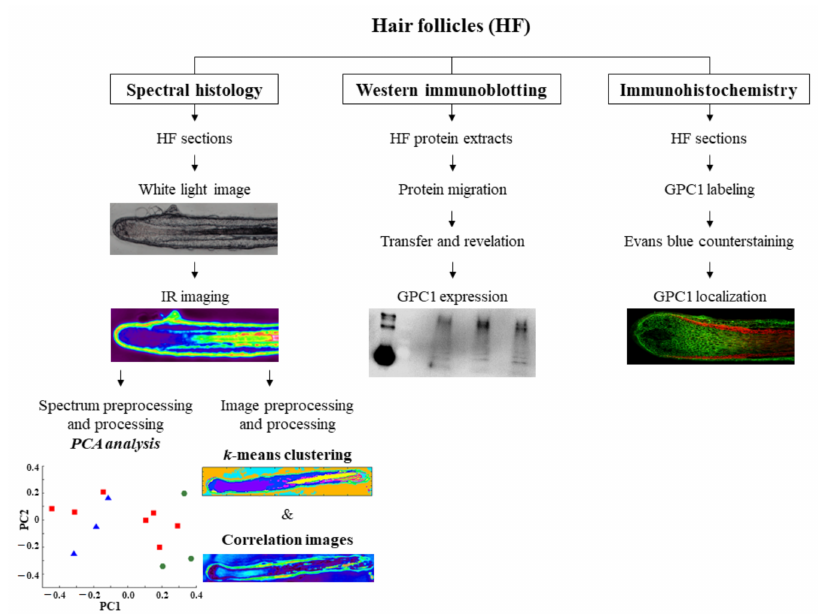
Figure 1. Workflow showing the methodological approach of hair follicle analysis by label-free infrared spectral histology, Western immunoblotting, and immunohistochemistry. Pictures shown here are only illustrated examples. PCA, principal component